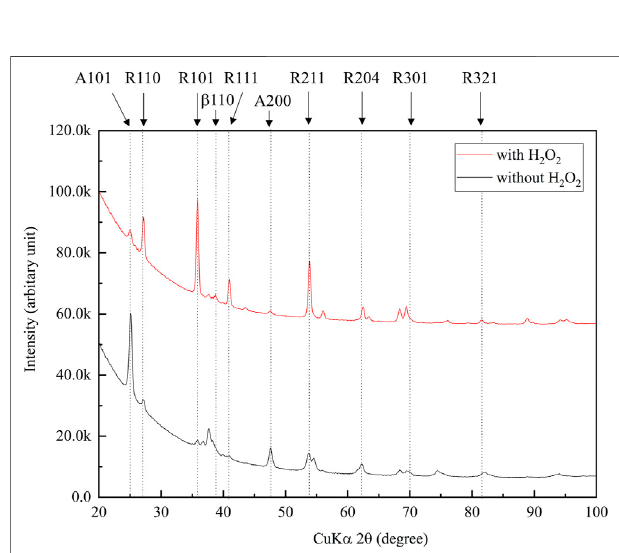
FIGURE 3 | XRD narrow scan pro fi les of the anodic oxides prepared in the sodium tartrate electrolyte with and without H 2 O 2 . The peaks of rutile- structured TiO 2 were accelerated in anodic oxide with H 2 O 2 . The sample size is n = 1 in each group. XRD: X-ray Diffraction.